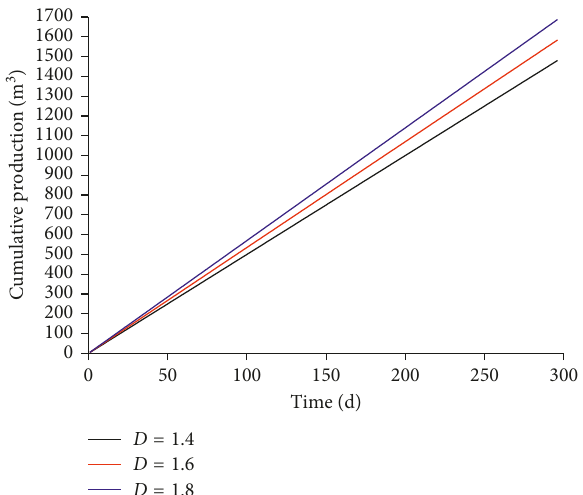
Figure 8: Cumulative production at a 300-day period with dif- ferent fractal